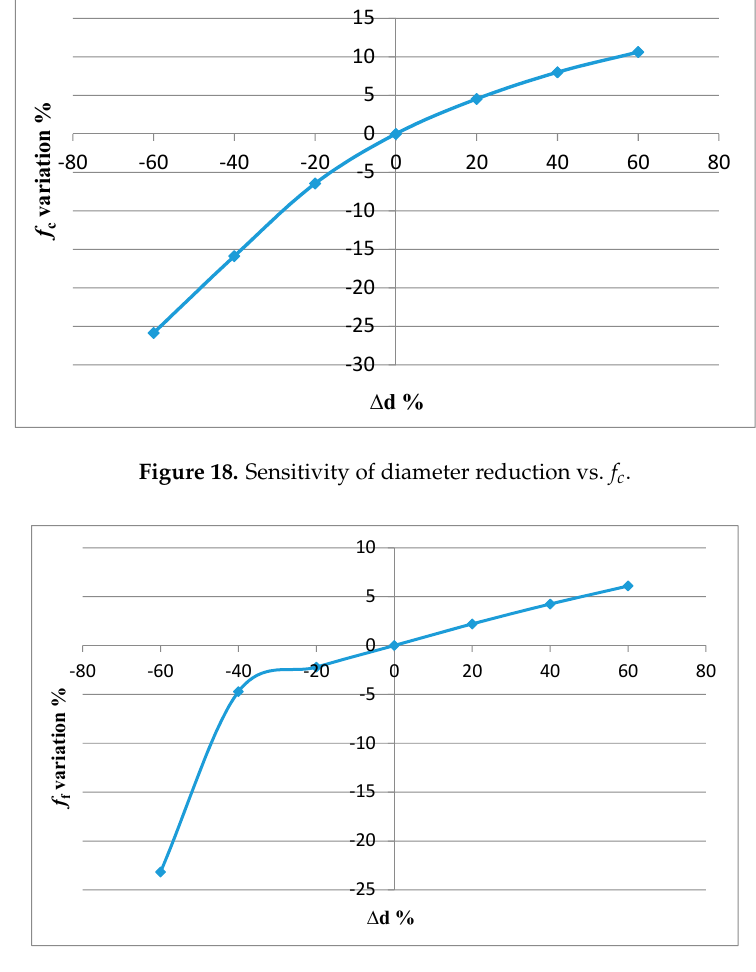
Figure 20. Variation of the ∆ d for 20% change in each constants of GNT model. 5. Discussion The numerical simulations of quasi-static and dynamic tests were also performed using Johnson–Cook damage model with the constants obtained by Majzoobi and Rahimi [34]. The results showed similar specimen profile after fracture for quasi-static test simulation, whereas in the high strain rate test J–C model predicted the specimen profile after fracture slightly more accurate than